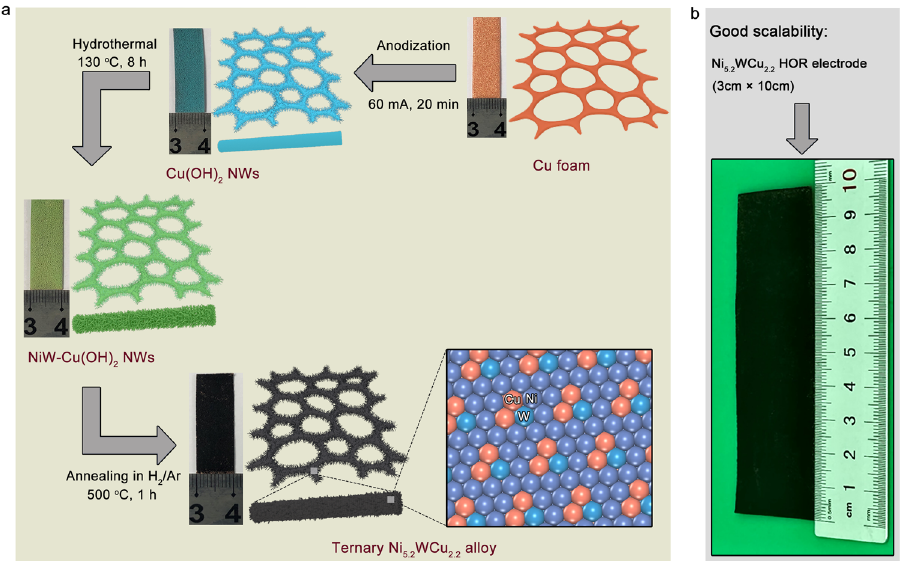
Fig. 1 Synthesis of ternary Ni 5.2 WCu 2.2 alloy. a Schematic illustration of the synthesis of Ni 5.2 WCu 2.2 alloy monolith. b Scaled-up synthesis of Ni 5.2 WCu 2.2 alloy monolith with a size of 3 cm × 10 cm using the identical